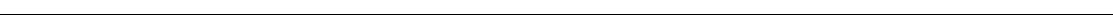
Fig. 1 Characterization of a rare natural mutation (( αα ) ALT ) con fi ned to MCS-R2. a Kindred showing patient (MC) homozygous for the ( αα ) ALT mutation and his heterozygote daughters. b Hemoglobin level and red cell parameters of MC and RC (who is heterozygous for the ( αα ) ALT mutation). c Peripheral blood smear, Giemsa stained, from patient MC, which shows anisocytosis and poikilocytosis with some irregularly contracted cells; scale bar represents 10 μ m. d Peripheral blood Hemoglobin H ( HbH ) preparation, brilliant cresyl blue stained, from patient MC, which shows HbH inclusions; scale bar represents 10 μ m. e Southern blot analysis using a probe speci fi c for the core of MCS-R2, which gives an 19 kb band on BglII digest genomic DNA from normal controls and RC but not from MC con fi rming the absence of this segment. f , g Analysis of enrichment of histone 4 (H4) acetylation f and SCL g by ChIP-qPCR in in vitro differentiated primary erythroid cells (Fibach culture 35 ) of MC harvested at intermediated erythroblasts stage (day 8 – 10 of Phase 2). The y -axis represents enrichment relative to ChIP input, normalized to 18S control region. Mean values are presented and error bars represent SD ( n = 3). Amplicons are labeled thus: RHBDF1, intronic amplicon within the Rhomboid gene RHBDF1 , used as a negative control; ALT insert, amplicon speci fi c for 39 bp insert; MCS-R1, the human MCS-R1 which is one of the other enhancers of α -globin; alpha-promoter, α -globin promoter; beta actin promoter, a control amplicon over the β -actin promoter. h Analysis of the abundance of panH4 acetylation across the α -globin locus by ChIP-seq in in vitro differentiated primary erythroid cells harvested at intermediated erythroblasts stage from patient MC ( lower track ) and a normal control ( upper track ), showing the absence of the peak over MCS-R2 in patient MC ( red dashed box